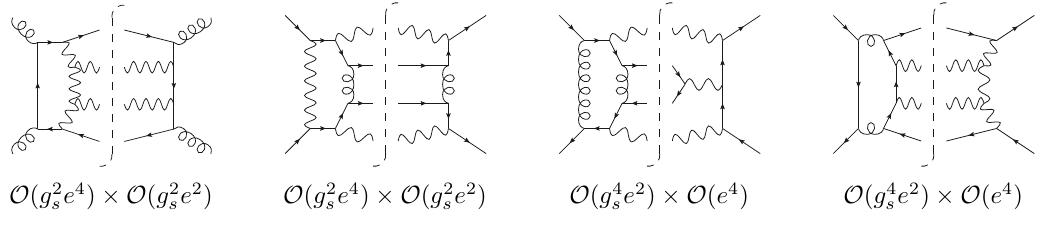
(cid:11) 3 ) for (cid:13)(cid:13) + jj ( (cid:11) 2 s O